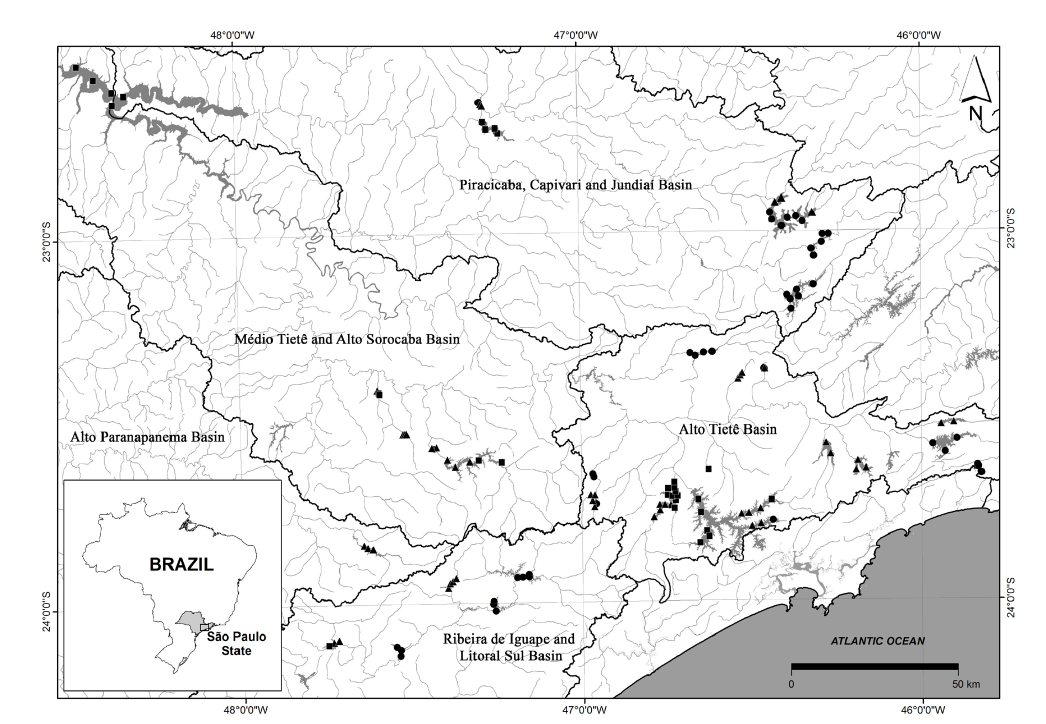
Figure 1. Map with the location of the 31 reservoirs studied (Southeastern Brazil). Black circles represent oligotrophic sampling sites, black triangles represent mesotrophic sampling sites, and black squares represent eutrophic sampling sites. Adapted from Bicudo et al.